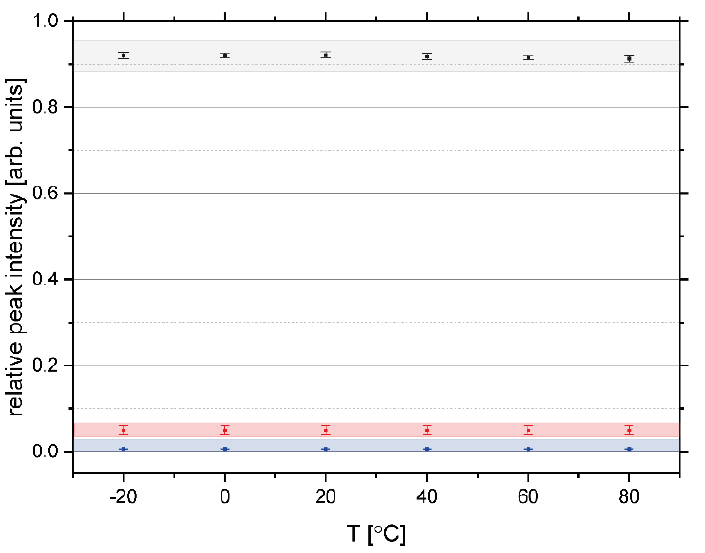
Figure 5. Relative integral intensities of the hydrogen ( black ), carbon ( red ) and oxygen ( blue ), obtained from fitting of the TOF NCS spectra recorded at a set of temperatures in the range of − 20 ◦ C to 80 ◦ C for the sample of rice pasta with the water content 0.1069 g/g d.m. The filled points with error bars denote the peak intensities.